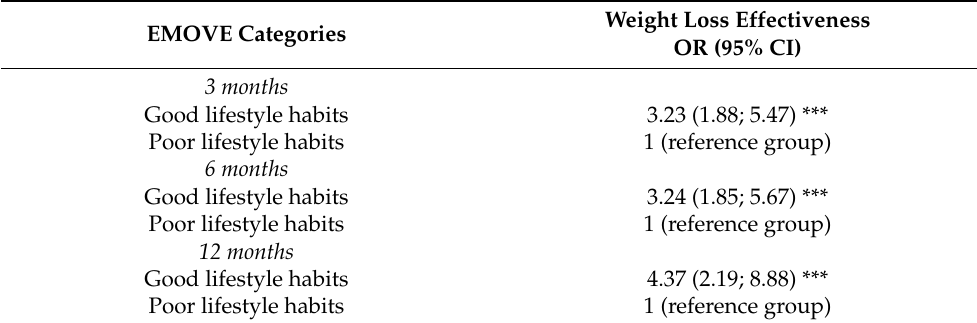
Table 2. Odd ratios (95% CIs) for weight-loss-response by EMOVE